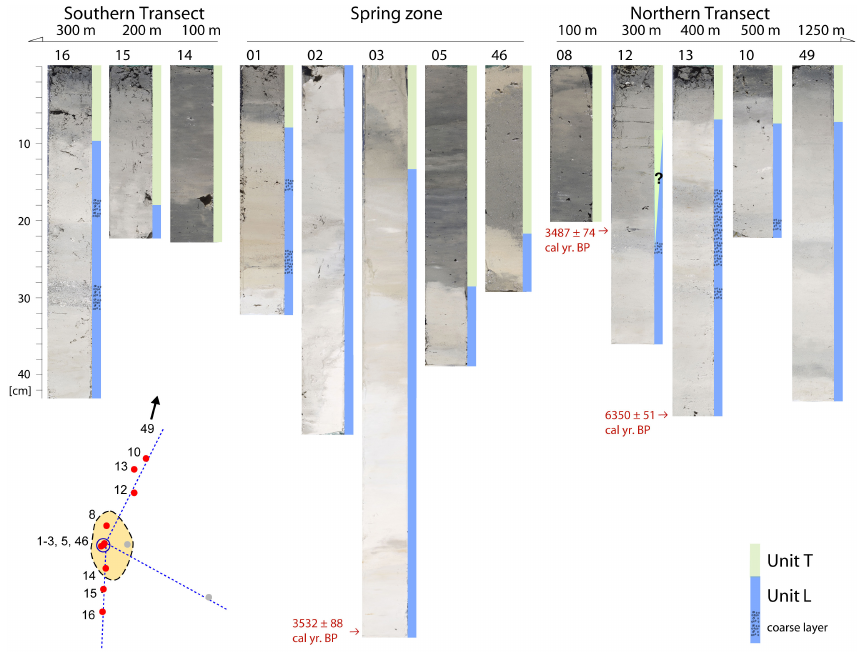
Fig. 6. Photographs of the cores from the northern and southern transects, as well as the subaquatic spring zone (middle). For location see corresponding core number in Fig. 2. Color bars to the right of core photographs indicate lithologic units T (green) and L (blue). Insert map shows location of displayed cores with red dots along the three transects (Fig. 2). Core photographs of the cores from the eastern transect are shown in Fig. 7.